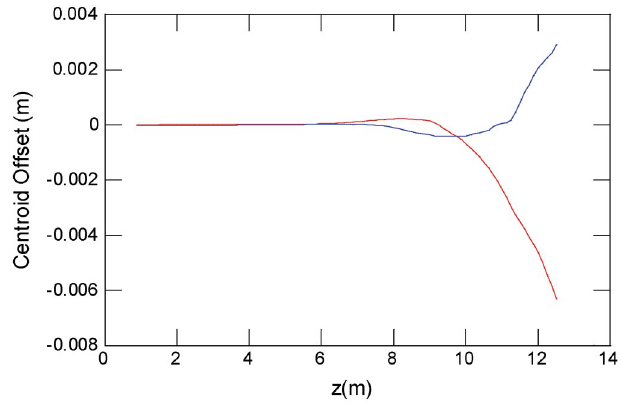
FIG. 27. (Color) Centroid of slice 800 ( 6 : 4 (cid:1) sec into pulse) versus distance for the commissioning geometry. The red line is for the horizontal centroid and the blue line is for the vertical centroid.